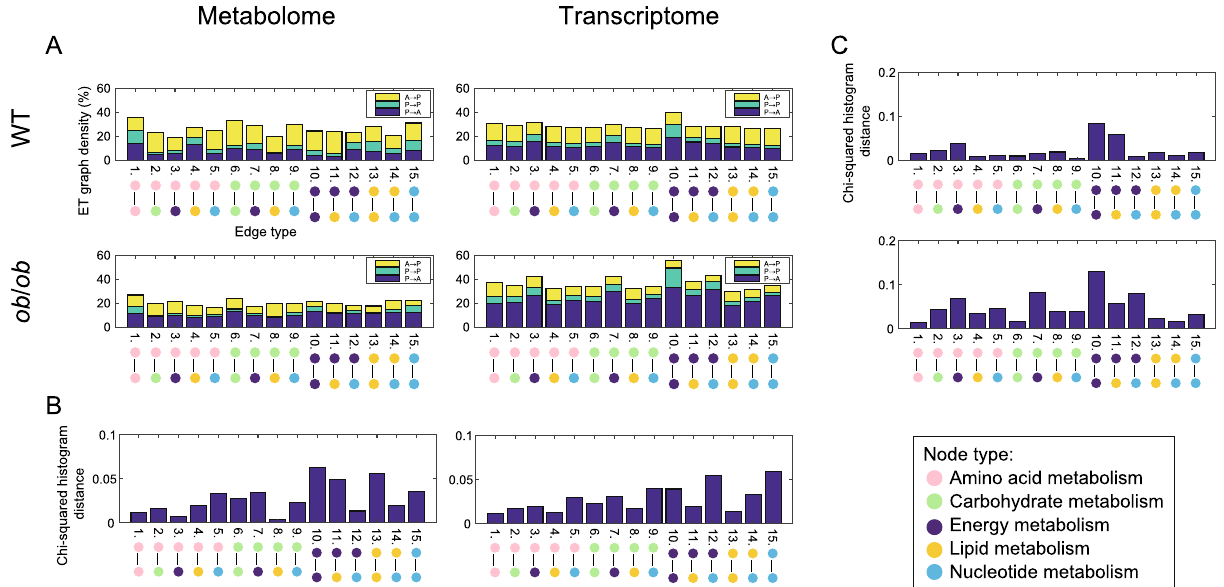
Figure 5. The ratio of OGTT response edge and comparison of the distribution of OGTT response edge in each edge type. ( A ) The ET graph density of each OGTT response edge (A to P, P to P, and P to A) in each ET in the metabolome (left column) and transcriptome (right column) of WT (upper row) and ob / ob (lower row), respectively. ( B ) The Chi-squared histogram distance of distributions of the ET graph density for the OGTT response edges between WT and ob / ob . ( C ) The Chi-squared histogram distance of distribution of the ET graph density for the OGTT response edges between the metabolome and